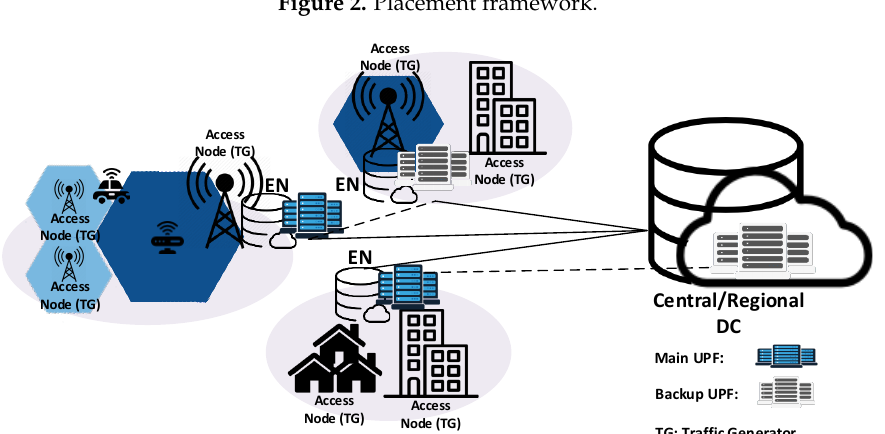
Figure 2. Placement framework.